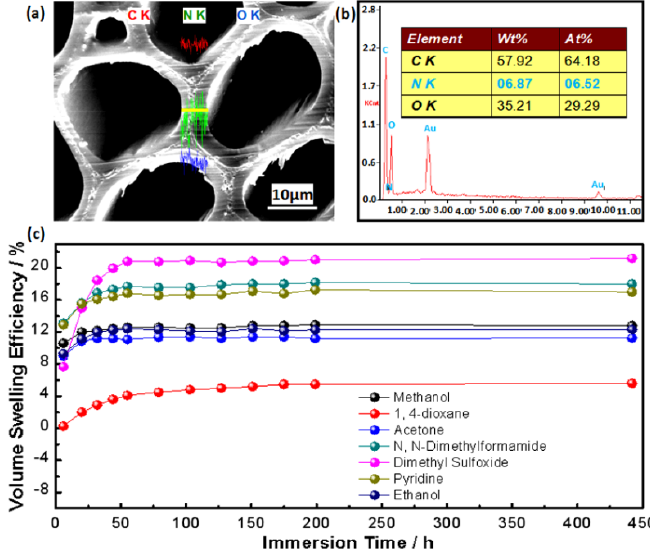
Figure 2. Wood cell wall bulking. ( a ) The N element distribution and ( b ) the element content ratio. ( c ) Variations of volume swelling efficiency (VSE) of cell wall swollen by seven polar solvents for immersion time of 442 h.